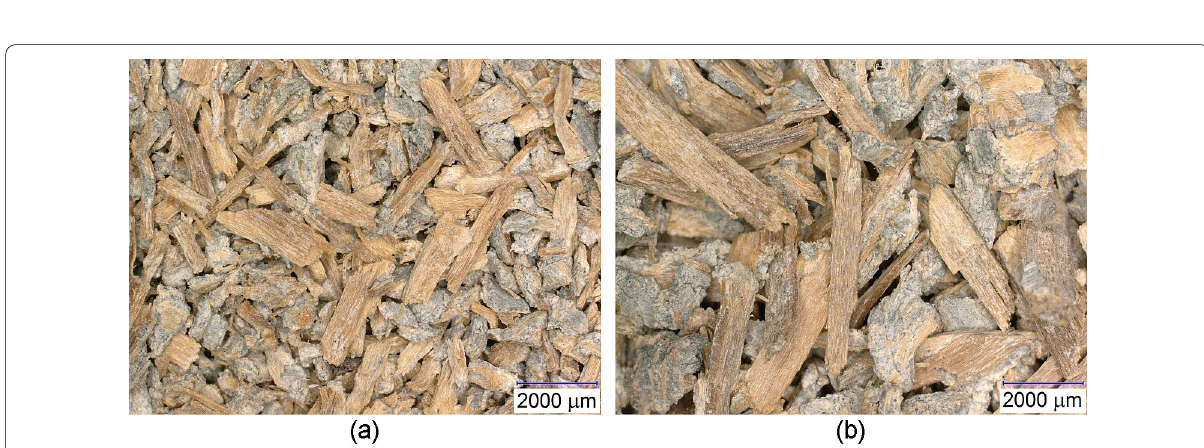
Fig. 4 Crushed cuttings from production of cement-bonded particleboards: separated secondary chips a 0.5 to 1.0 mm (magnification 10x) b 1.0 to 2.0 mm (magnification